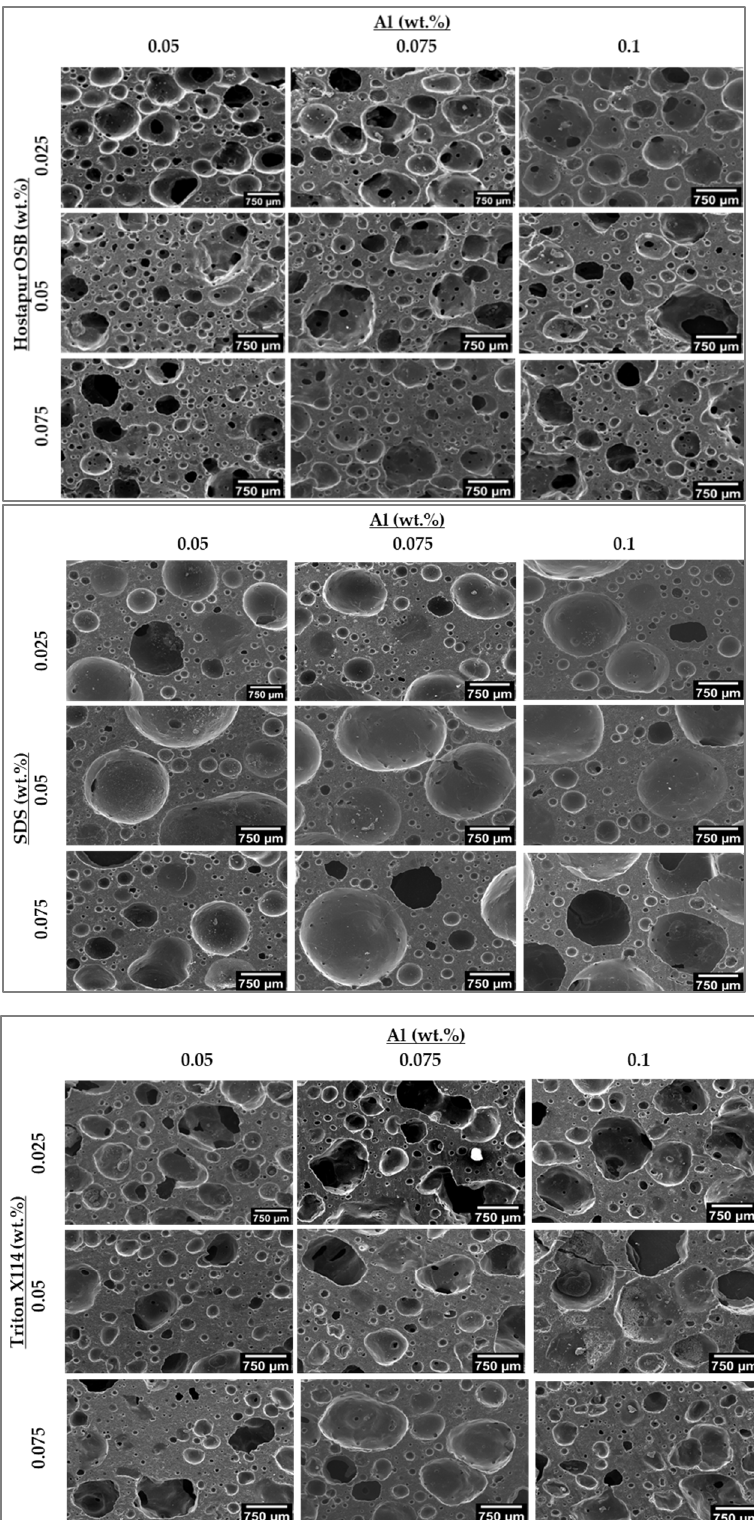
Figure 4. Optical microscope photographs of samples produced using various surfactants.